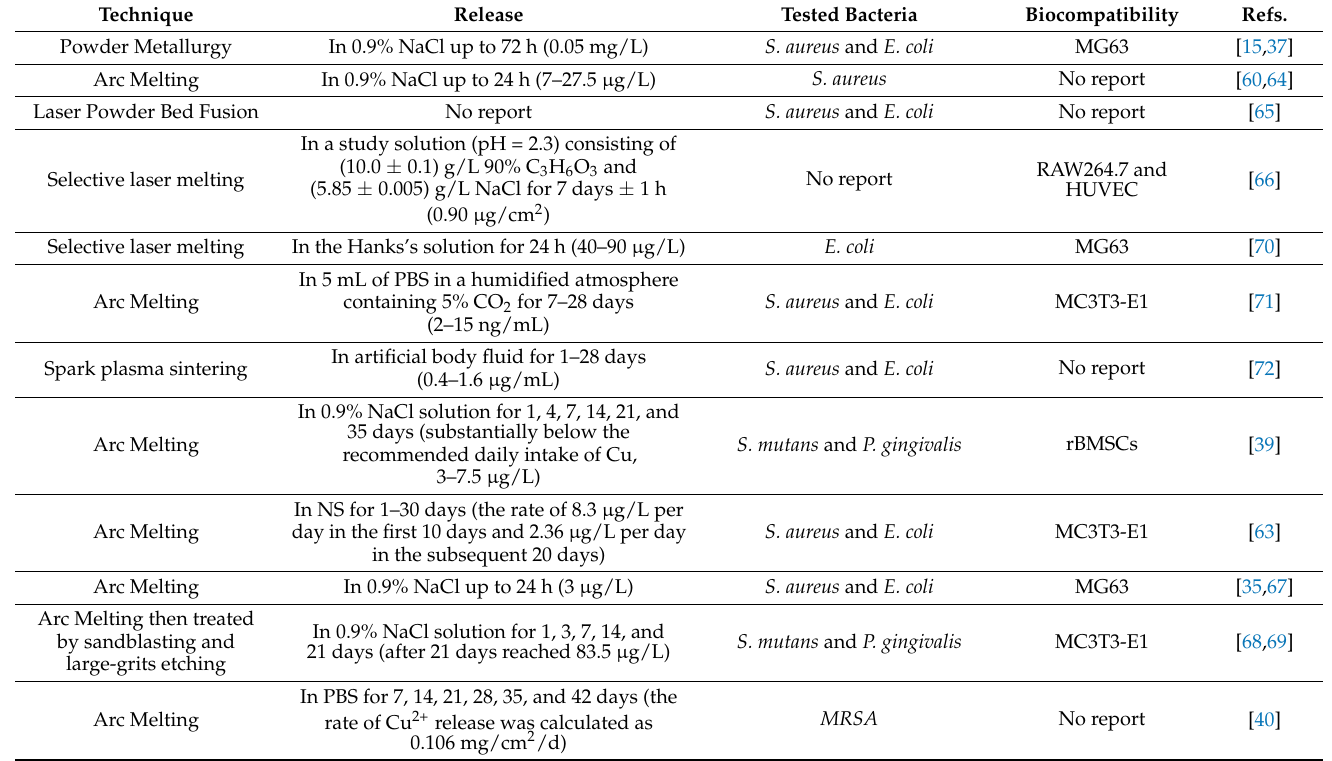
Table 1. Preparation technology and related properties of Ti-Cu